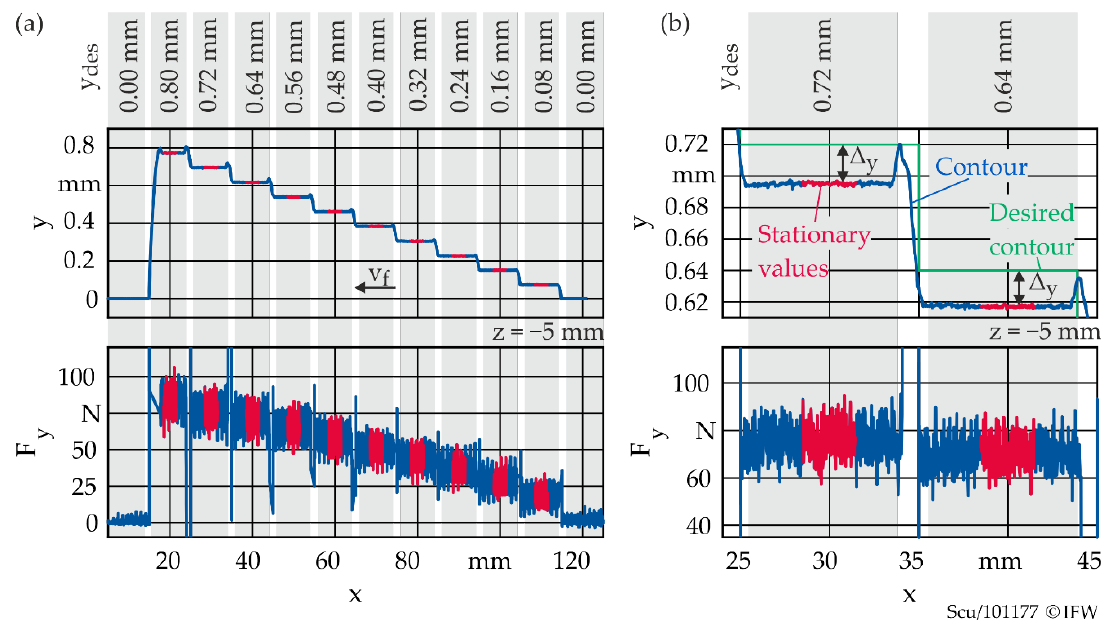
Figure 9. ( a ) Contour and feed normal force for stepwise increased infeed. ( b ) Detailed view with desired contour and deviation.